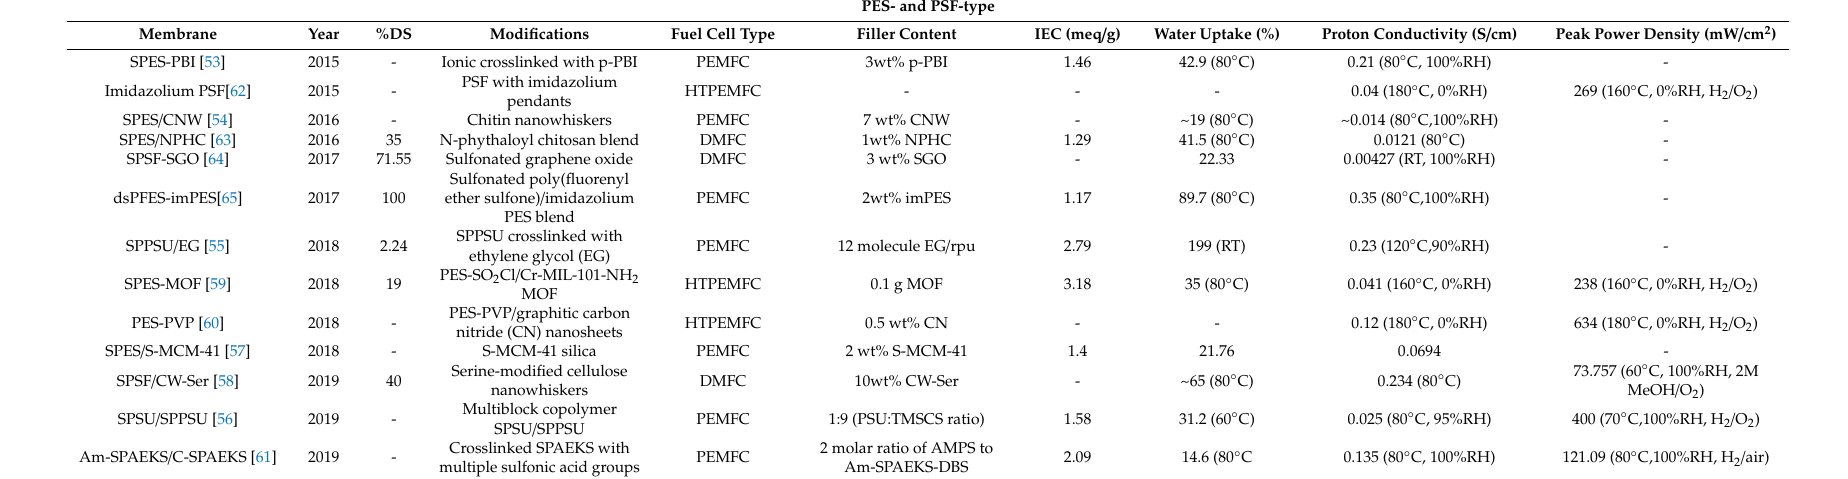
Table 5. Uptake and electrochemical properties of PES- and PSF-type PEMs. PES- and